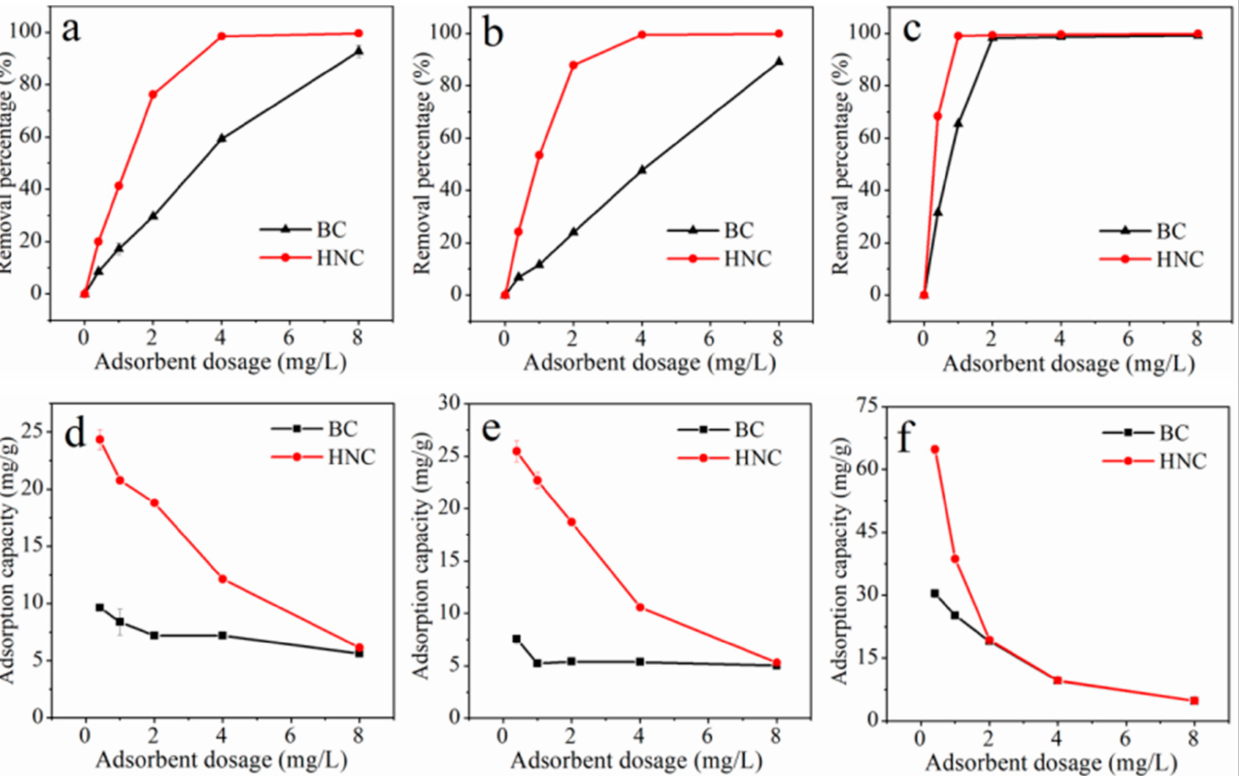
Figure 4. Effect of BC and HNC dosage on the adsorption of Cu 2+ ( a , d ), Cd 2+ ( b , e ) and Pb 2+ ( c , f ) at pH of 5.5, time of 240 min, initial concentration of Cu 2+ , Cd 2+ and Pb 2+ of 50 mg/L and temperature of 298.15